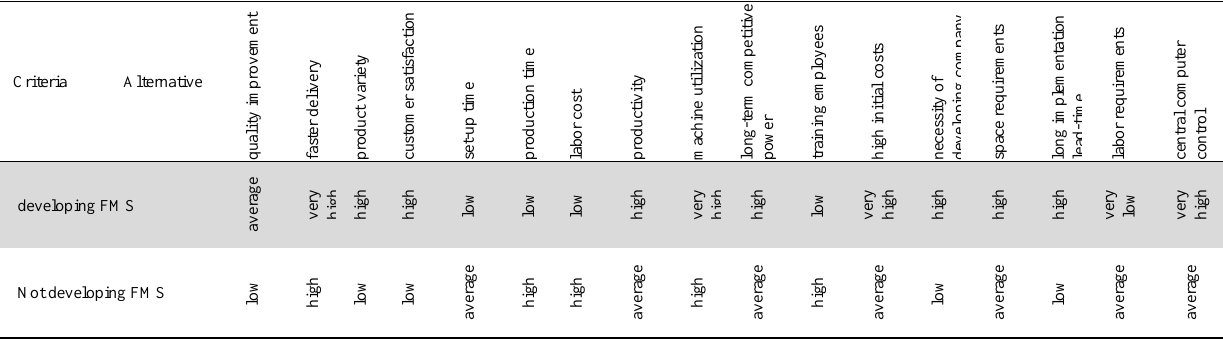
Decision matrix